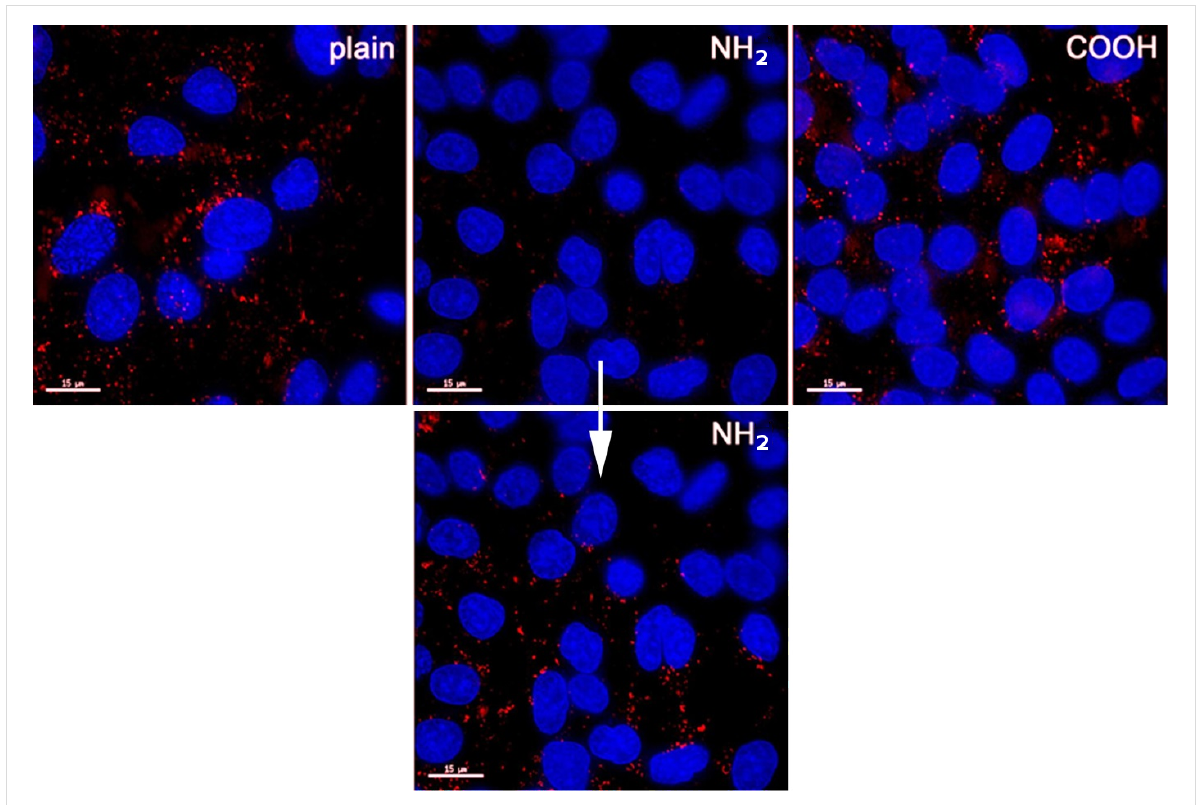
Figure 2: Cellular uptake of aSNPs with different surfaces in A549 (–plain, –NH 2 , –COOH; 50 µg/mL). The cells clearly internalized all three aSNPs after an incubation time of 4 h in serum-free medium. An approximate quantification of cellular uptake via fluorescence intensity measurement of the images could not be conducted due to the varying fluorescence intensities of the aSNP labeling itself. Comparing all three aSNPs using same inten- sity scale, a very low signal is observed for aSNP–NH 2 . However, after upscaling the intensity individually, a clear uptake is also observed for aSNP–NH 2 . Images were taken by a wide field fluorescence microscope (Applied Precision, DeltaVision), aSNP are displayed in red (496 nm), nuclei are stained with Hoechst 33433, scale bar 15